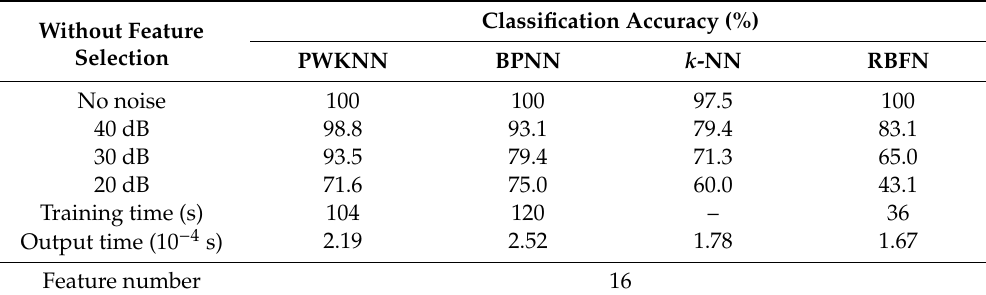
Table 2. The classification results with feature